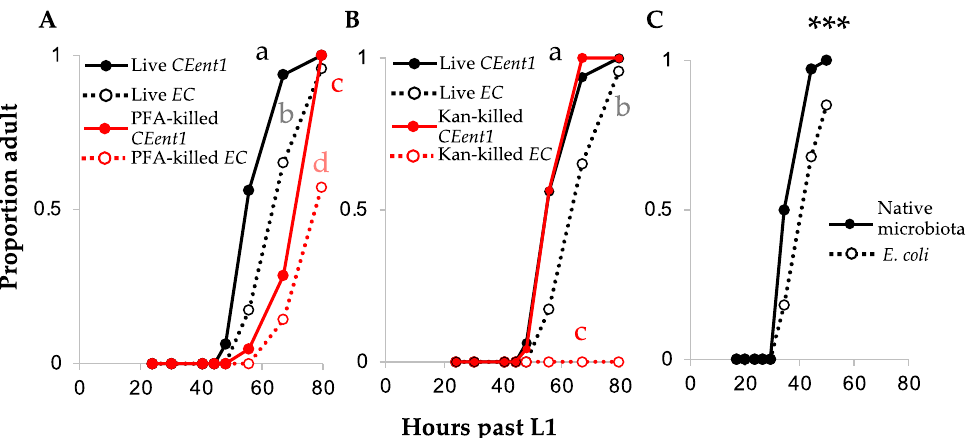
Figure 1. Naturally associated C. elegans microbes accelerate worm development dependent on the viability of the microbes. Shown are development time-courses (15 ◦ C) for wildtype worms raised on E. coli (EC) or on the Enterobacter hormaechei worm gut isolate ( CEent1 ), live, PFA-killed ( A ), or kanamycin-killed ( B ); shown are the results for one experiment, separated into two panels for clarity; n = 20 worms per group. Results shown in B were reproduced in 3 independent experiments (see Figure S2). Letters indicate statistically different curves (Kaplan–Meier analyses, post hoc p -values < 0.004). ( C ) Complex soil microbiotas similarly accelerate host development. A representative